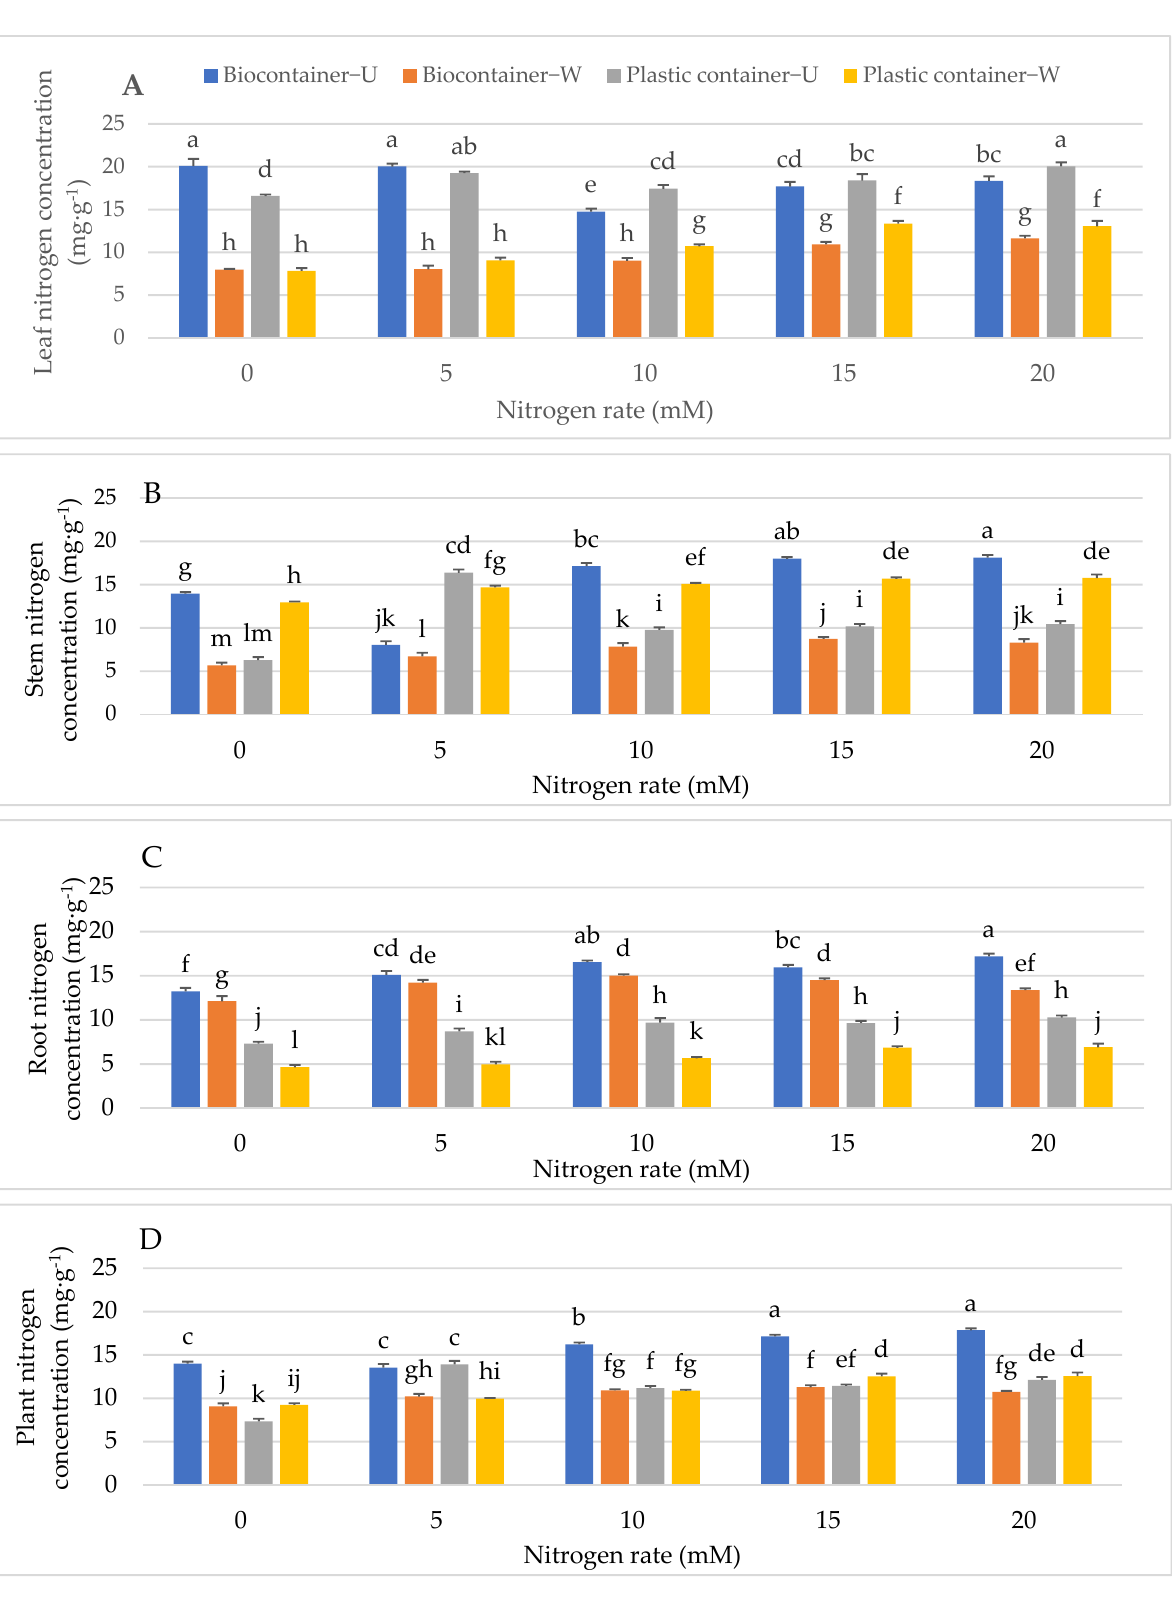
Figure 1. Nitrogen concentrations of Encore ® azalea ‘Chiffon’ in leaves ( A ), stems ( B ), roots ( C ), and averaged in the entire plant ( D ) affected by the interaction among N rate, container type, and foliar urea spray. Different lower-case letters in each chart suggest significant difference among all treatment combinations indicated by Tukey’s HSD test at p ≤ 0.05.